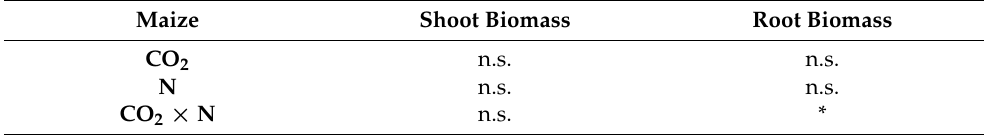
Table 5. Two-factor ANOVA analyses for maize biomass. Maize Shoot Biomass Root Biomass CO 2 n.s. n.s. N n.s. CO 2 × N